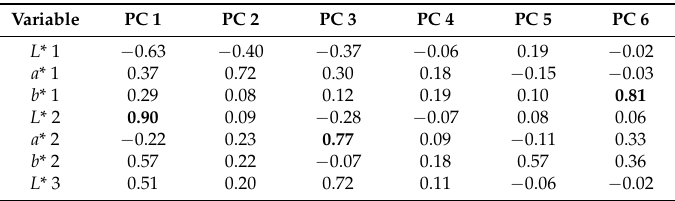
Table A5. Axis loadings of the preparatory PCA used to assess the broad-sense heritability of male body coloration after Varimax rotation. Loadings > 0.75 are highlighted in boldface.